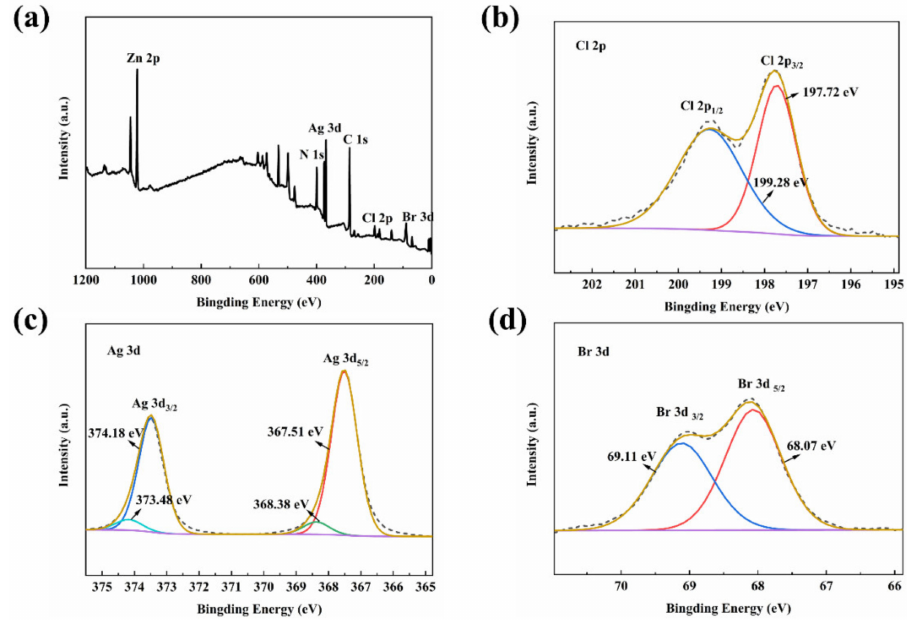
Figure 4. XPS spectra of AgBr/AgCl@Z3 composition: ( a ) survey, ( b ) Cl 1s, ( c ) Ag 3d, and ( d ) Br